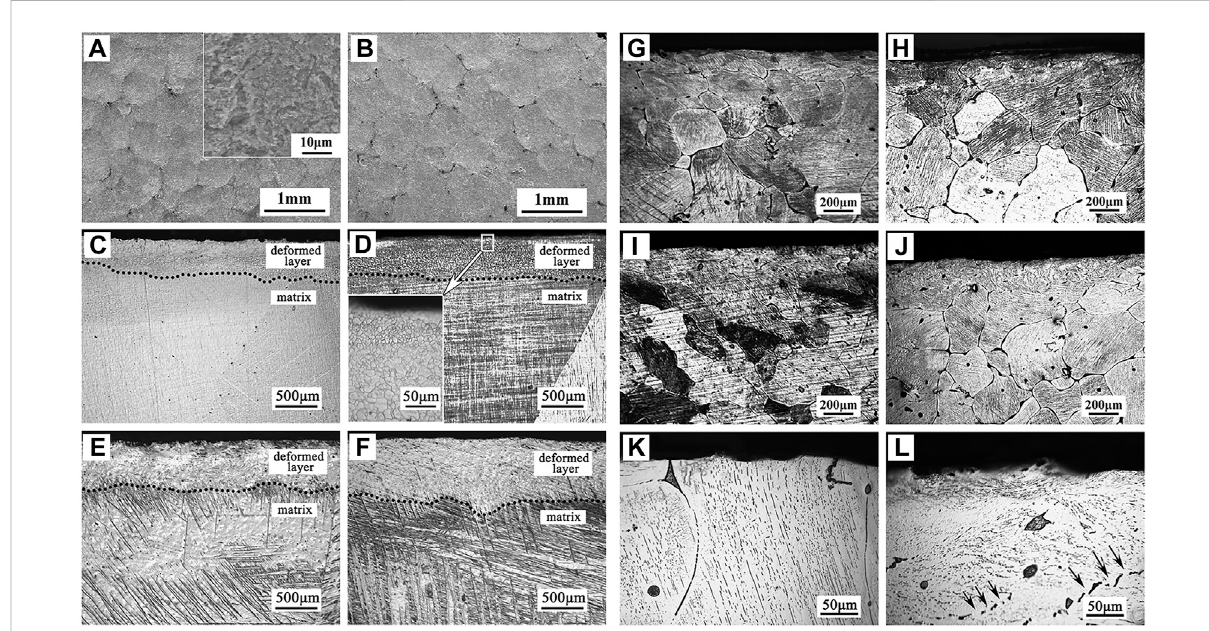
FIGURE 8 Surface morphologies of (A) SMATed pure Mg, and (B) SMATed Mg-1Ca alloy; cross-section morphologies of (C – F) SMATed pure Mg for different time, (G – J) SMATed Mg-1Ca alloy for different time, and high magni fi cation images of (K) untreated and (L) SMATed Mg-1Ca alloy. Reprinted with permission from reference (Chen et al., 2019a),